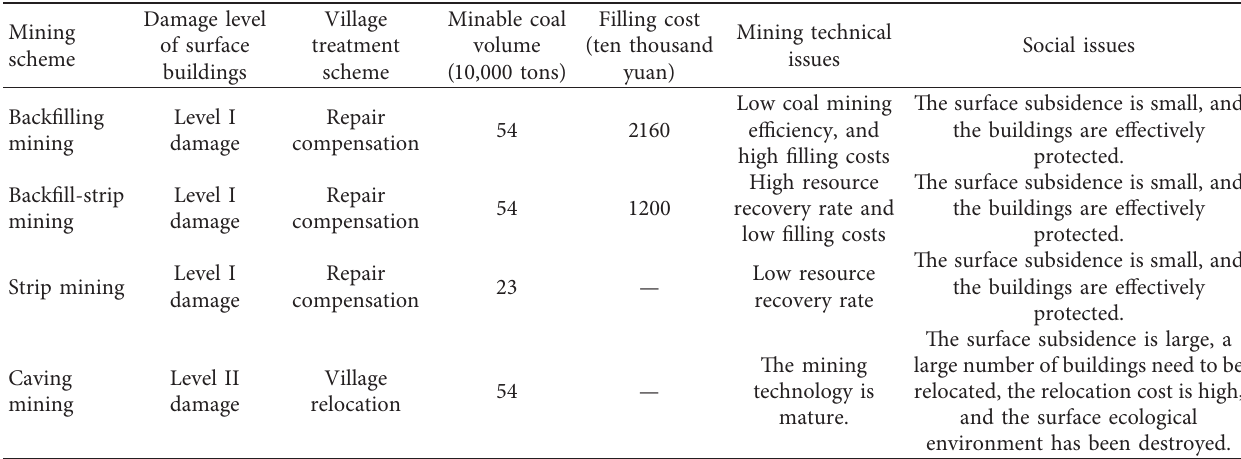
Table 8: Benefit comparison of different coal mining schemes under buildings.